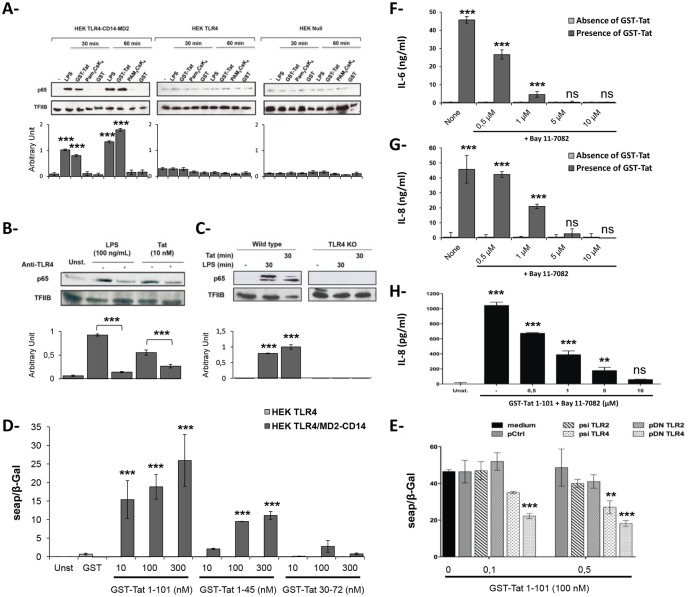
HIV-1 Tat activates NF-κB pathway ina TLR4 dependent manner.(A) HEK null, HEK-TLR4, HEK-TLR4-CD14-MD2, (B) primary human monocytes, pretreated or not with anti-TLR4 (1μg/ml) or, (C) peritoneal macrophages from wt or TLR4 KO mice cells were stimulated during 30 or 60 minutes with total Tat protein (10 nM). Similar stimulations were also conducted with GST, or Pam3CSK or LPS TLR ligands. p65 subunit of NF-κB was detected by Western-Blot in the nucleic fraction of the cells. Quantification of the band obtained from 3 independent experiment was performed using Image J Software. (D-E) HEK TLR4 or HEK expressing TLR4-CD14-MD2 cell lines were co-transfected with same amounts of the NF-κB reporter plasmid together with pORF-LacZ and then stimulated with increasing amounts of GST-Tat 1–101, GST-Tat 1–45, GST-Tat 30–72 or GST alone as negative control (D). In (E), cells were also co-transfected with the indicated amounts of the plasmid encoding siRNA or Dominant Negative (control, TLR4 or TLR2). After 24h, cells were stimulated with total Tat or its deleted mutants. After 24h of stimulation, NF-κB driven SEAP-reporter gene expression was measured in the culture supernatants. For normalization, cells were lysed and expression of β-galactosidase gene was analyzed. (F-H) IL-6 and IL-8 cytokine production was analyzed in the culture supernatants of HEK-TLR4-MD2-CD14 cells (F) and human monocytes (G-H) previously treated with non-toxic concentrations of Bay11-7082 (0.5–10μM). Asterisks represent P values: *, P ˂ 0.05; **, P ˂ 0.01; ***, P ˂ 0.001, ns non significant.